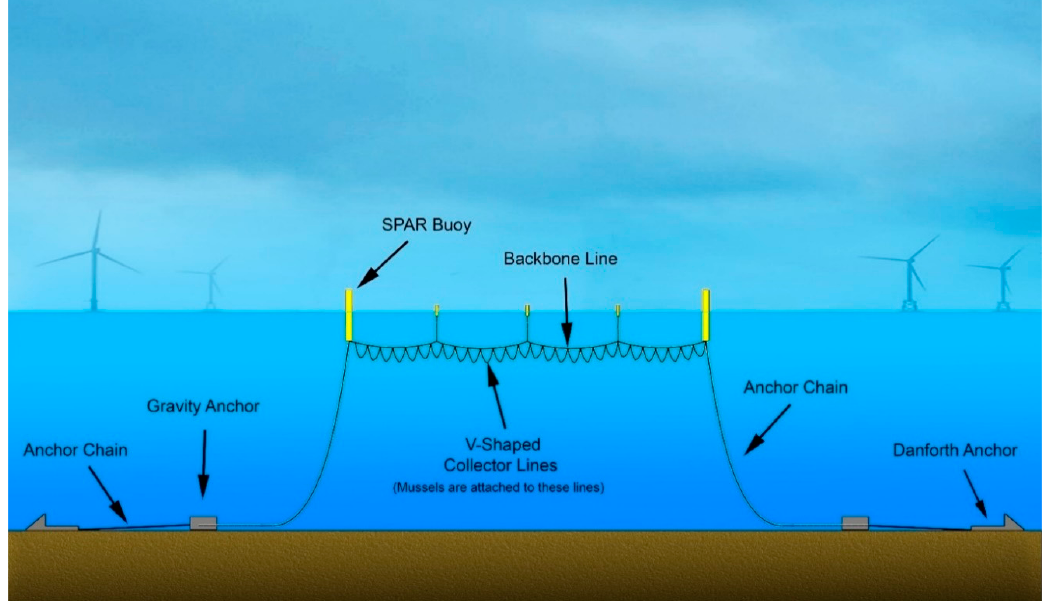
Figure 2. Illustration of the Edulis test setup line in Belwind (length not drawn to scale).